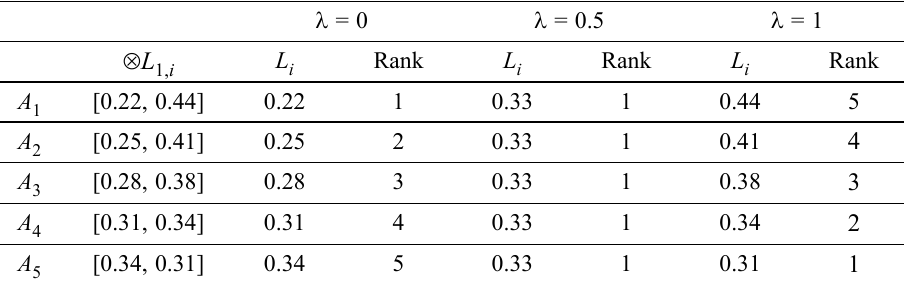
Table 17. The ranking results in the case of grey ideal point λ = 0 λ =